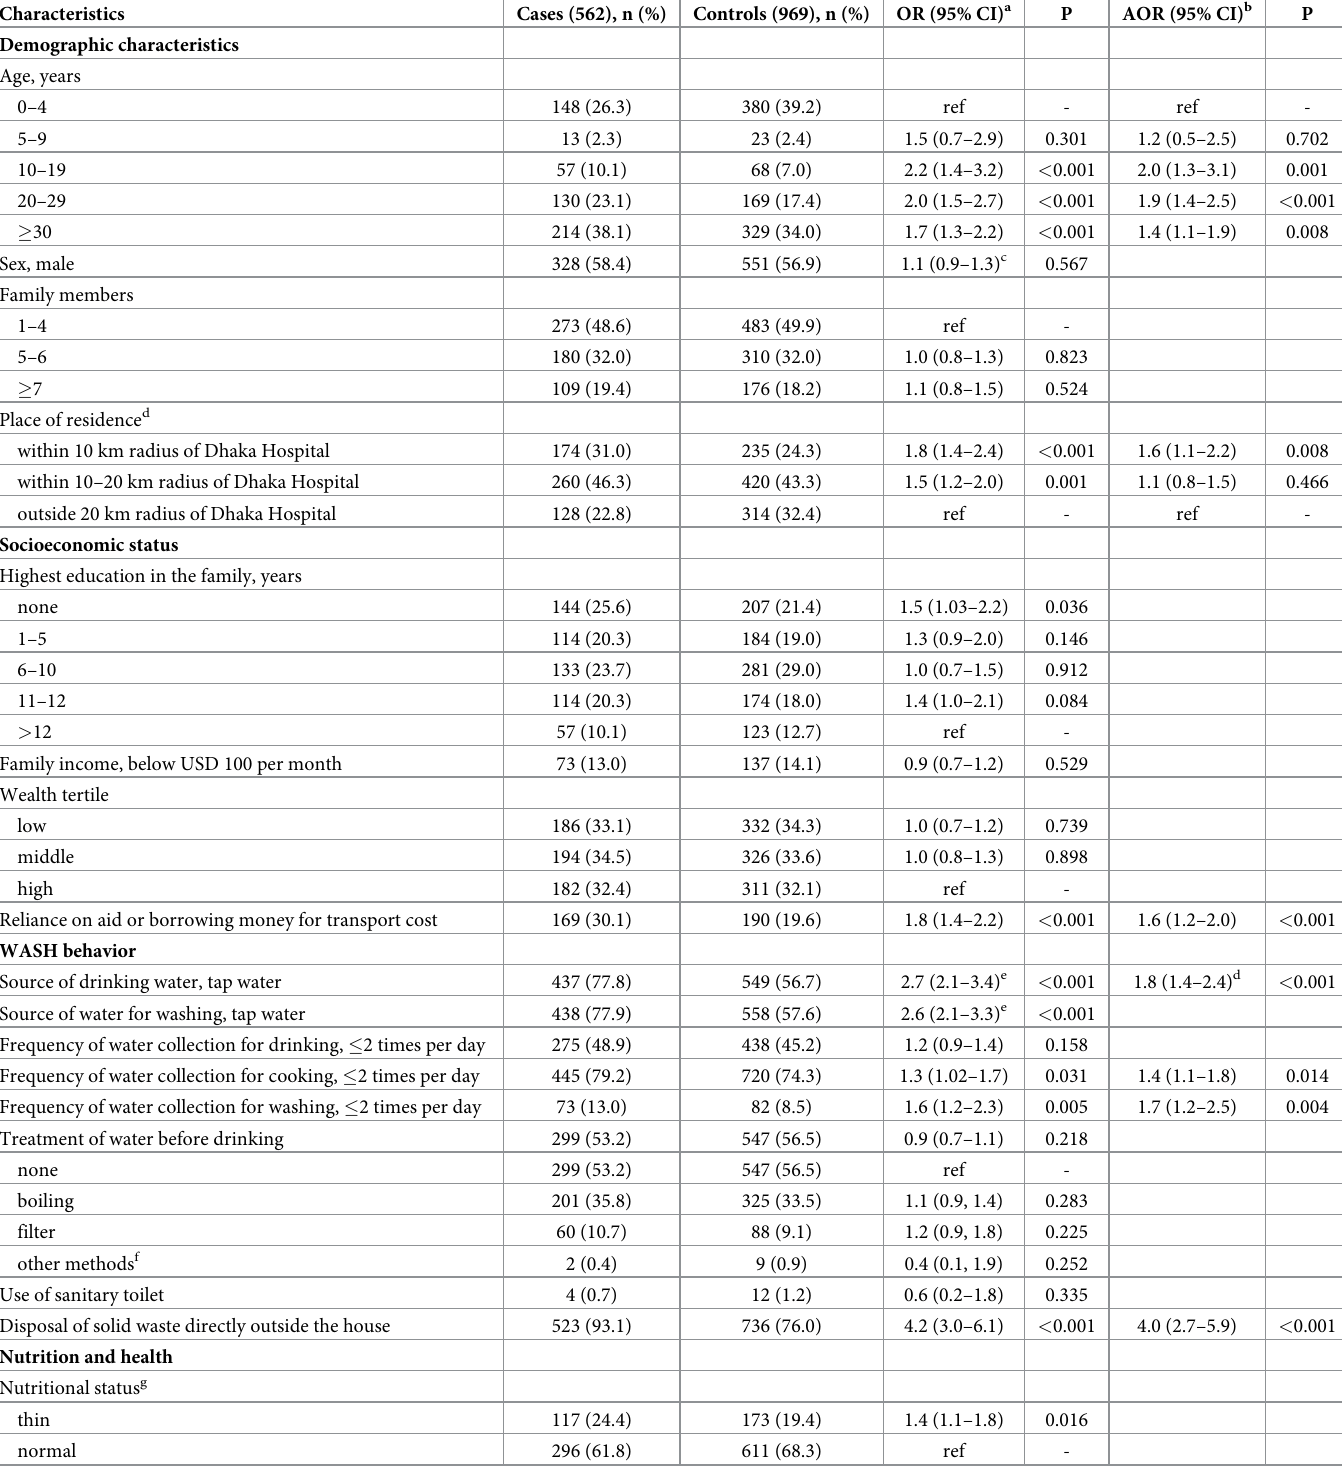
Table 1. Characteristics of DDSS-enrolled patients treated at icddr,b Dhaka Hospital during the epidemic (cases) and the comparison period (controls) and odds ratio of diarrhea during the epidemic (compared to the comparison period) for non-pathogen factors.